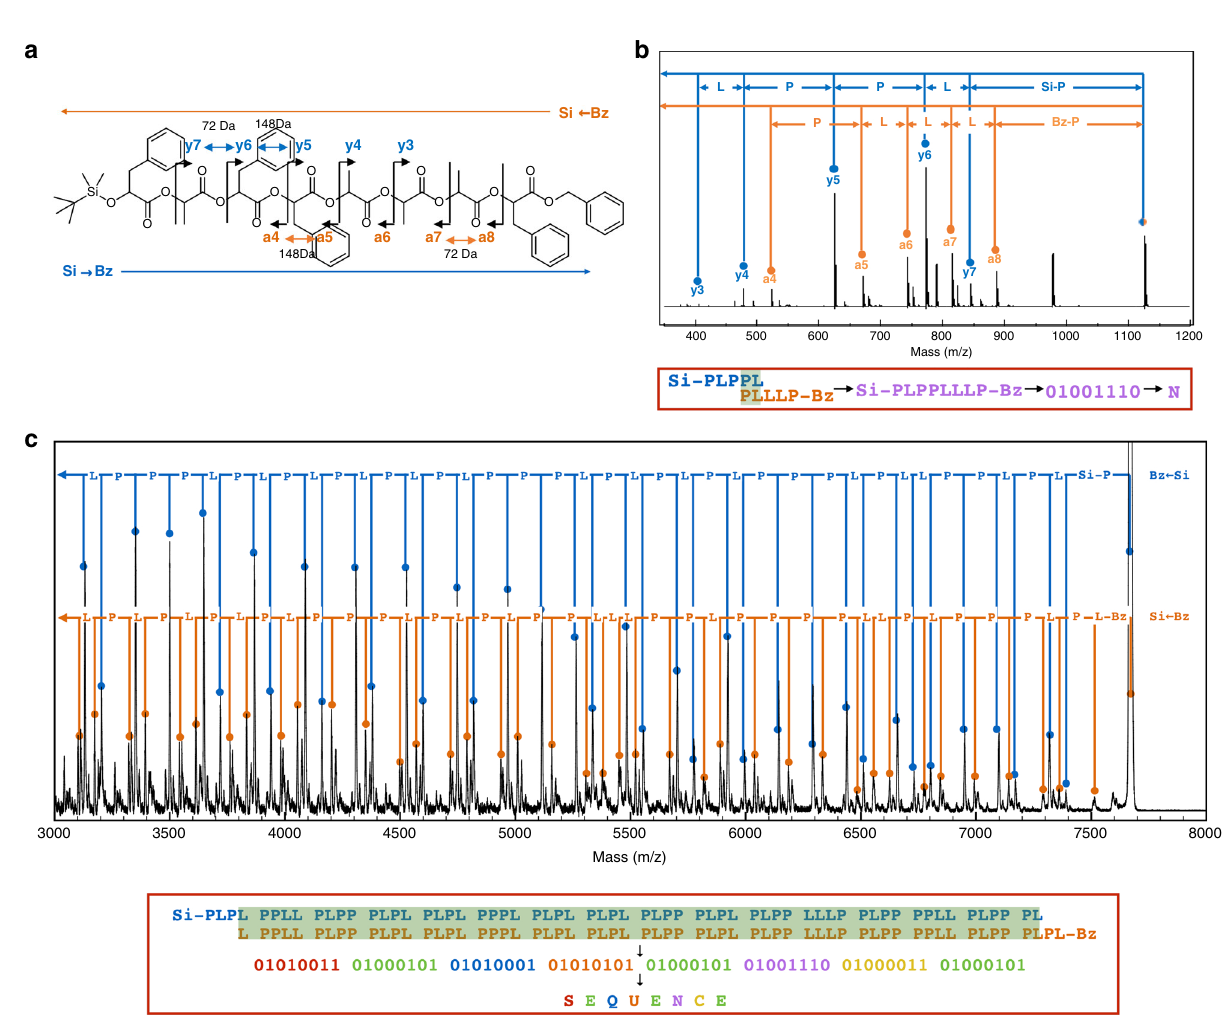
Fig. 3 Decoding of sequence-de fi ned PcL by tamdem mass spectrometry. a Fragmentation of 8-bit PcL under MALDI-TOF MS/MS experiments showing a series of a i and y i fragments. b MALDI-TOF MS/MS spectrum of a PcL, in which 8-bit information corresponding to the letter N was stored. Two series of fragments (a i and y i fragments) could be read simultaneously in the spectrum. The PcL sequence was decoded by reading the spectrum in both directions relative to the molecular ion peak [M + Na] + . The deciphered chemical sequence (Si-PLPPLLLP-Bz) was converted to digital code (01001110), which represented the letter N. c Tandem mass sequencing of the entire 64-bit information stored in the PcL. The entire chemical sequence was decoded using a single mass spectrum, followed by conversion to digital information to read the word SEQUENCE (red